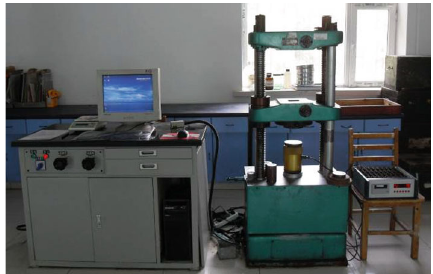
Figure 4: DNS100 microcomputer controlled electronic test